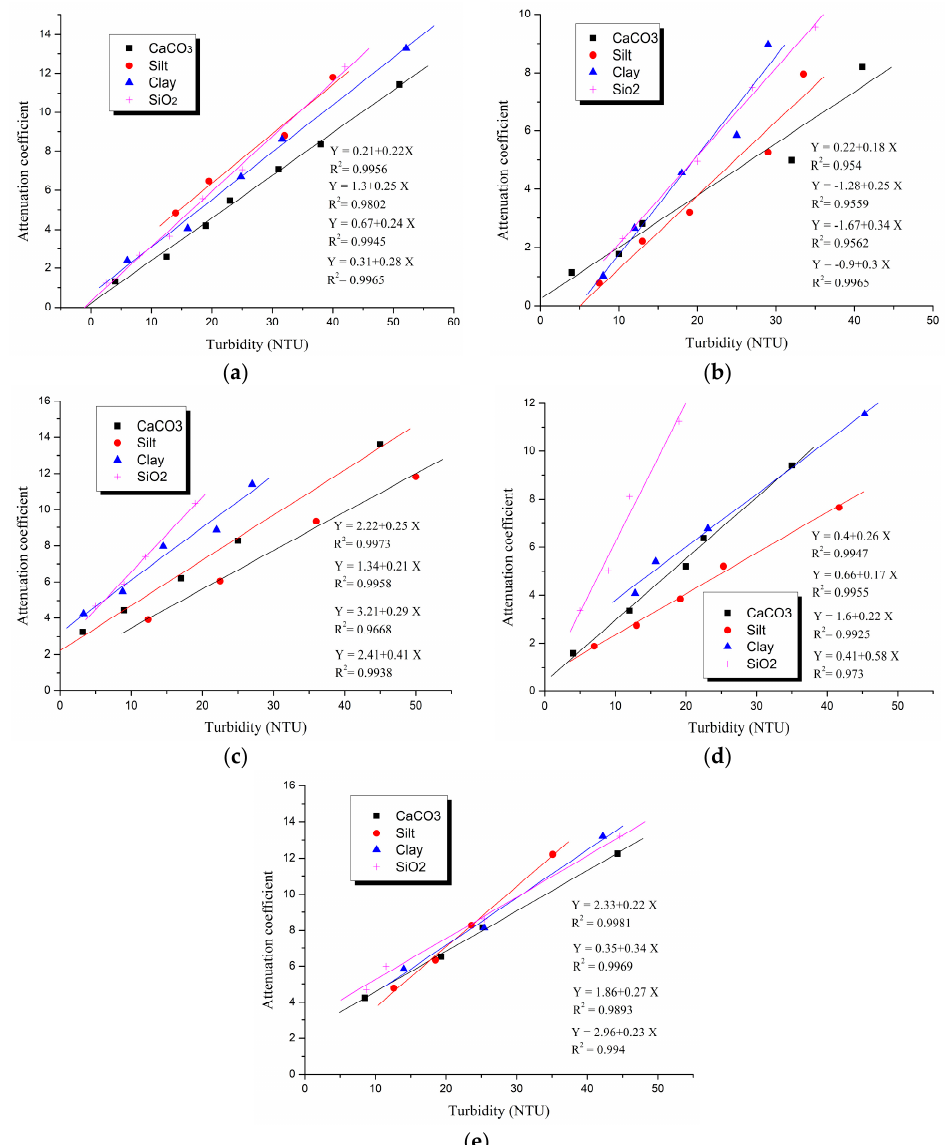
Figure 2. Attenuation coefficient—turbidity curves using different wavelength lasers: ( a ) 405 nm; ( b ) 405 nm; ( c ) 532 nm; ( d ) 650 nm; ( e ) 808 nm.